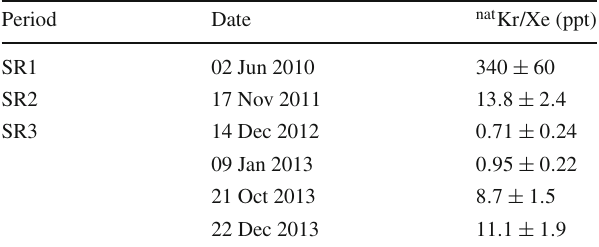
Table 2 Overview of the nat Kr concentration measurements that were performed during the three SRs using mass spectrometry Period